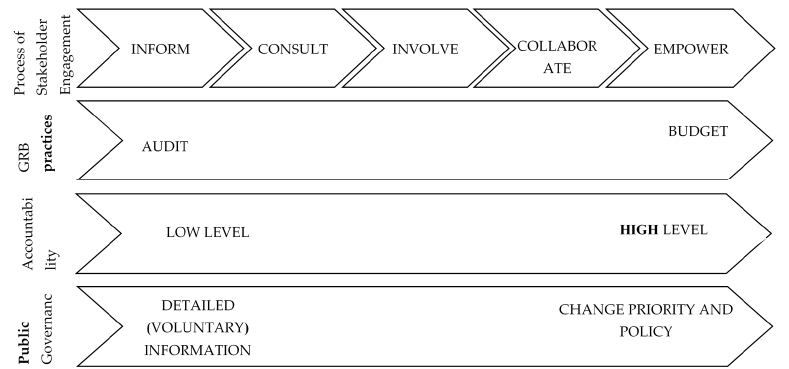
Figure 1. Summary of the above considerations on stakeholder engagement.